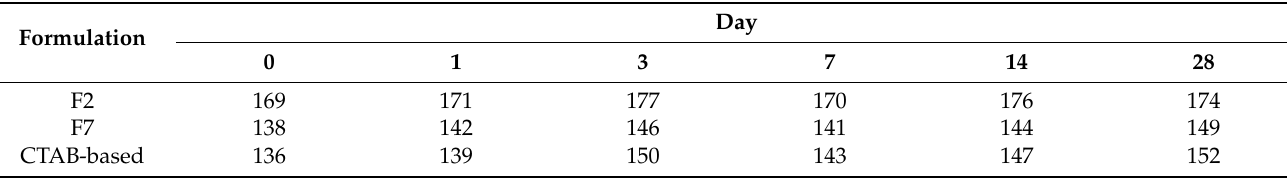
Table 7. Osmolality (mOsm/kg) of Formulation F2, Formulation F7, CTAB-based NEs loaded with triamcinolone acetonide over a period of 28 days.